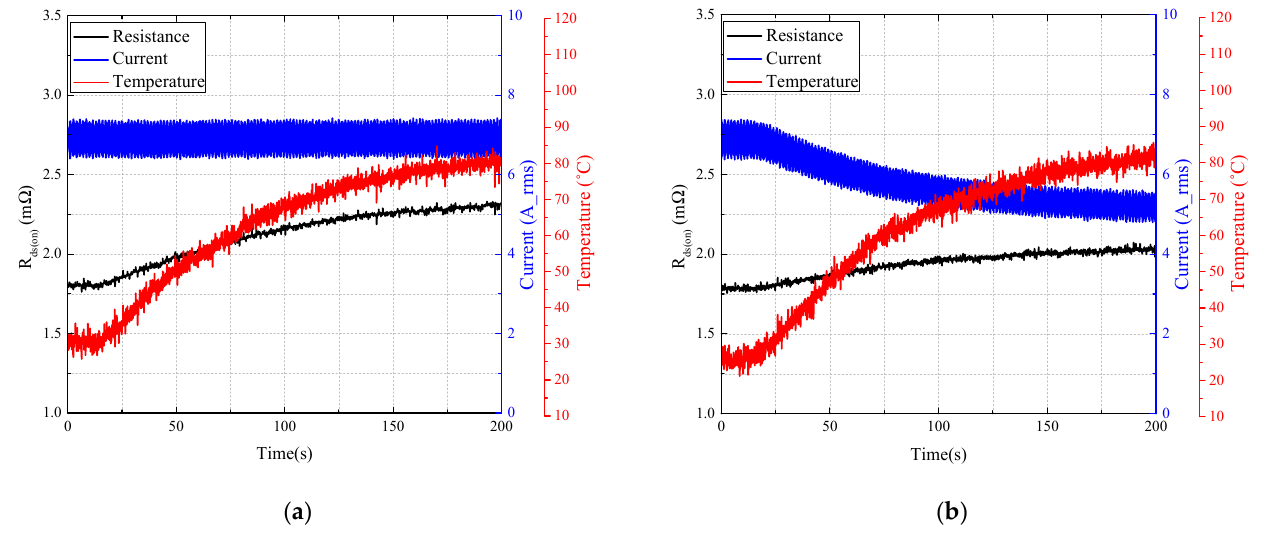
Figure 12. ( a ) 700 rpm@10 A pk Rds(on), temperature, current (rms) waveform; ( b ) 130 rpm@5 A pk Rds(on), temperature, current (rms).